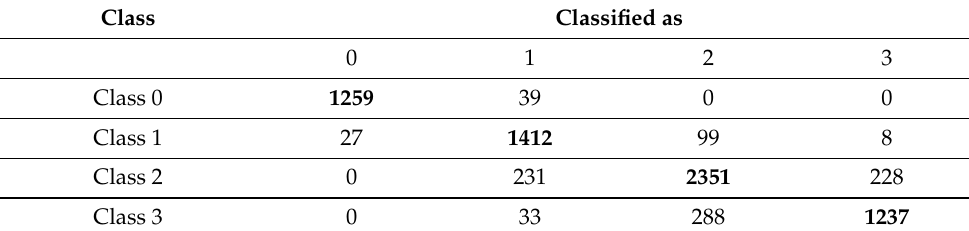
Table 12. The classification confusion matrix of the method M 8 × 6 E − d 1 on the test